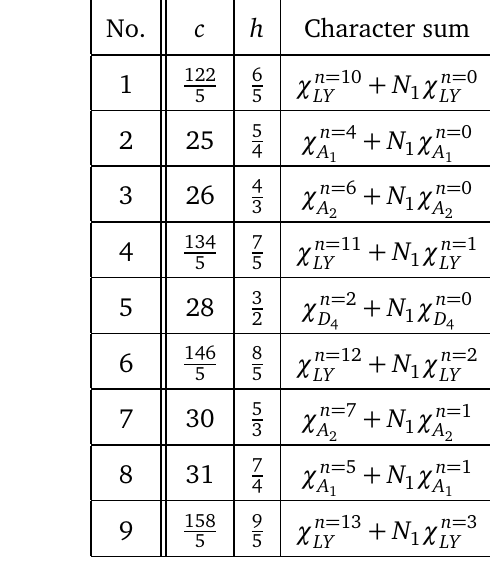
Table 2: (cid:96) = 6 pairs obtained by addition of quasi-characters